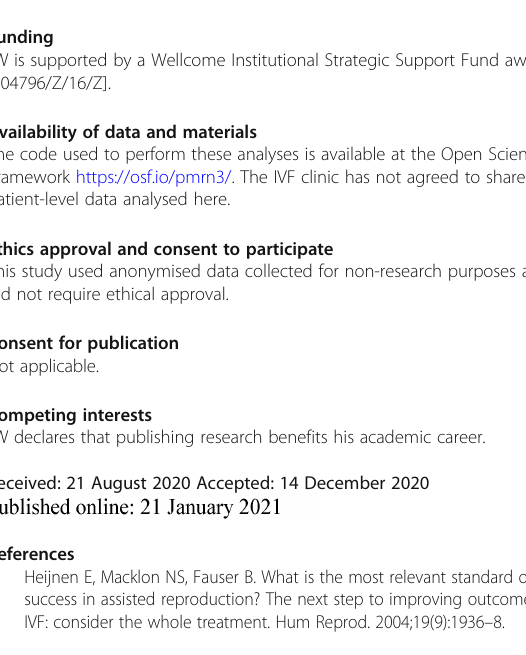
Additional file 1: Table A1. Estimated correlation matrix from the pretreatment joint model. Table A2. Estimated correlation matrix from the dynamic joint